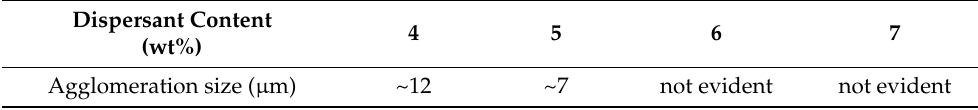
Table 4. Agglomerate sizes of ZF2